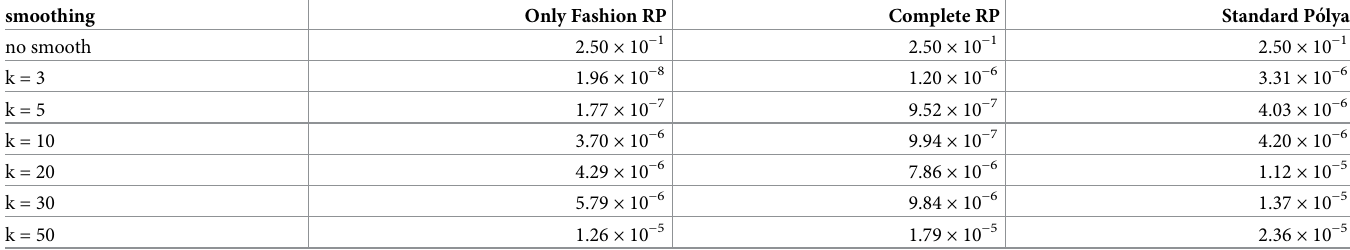
Table 15. “Migration” ( T = 0, entire, D = 3 0 , S = 100 slots of equal size): MSE for different levels of smoothing. smoothing